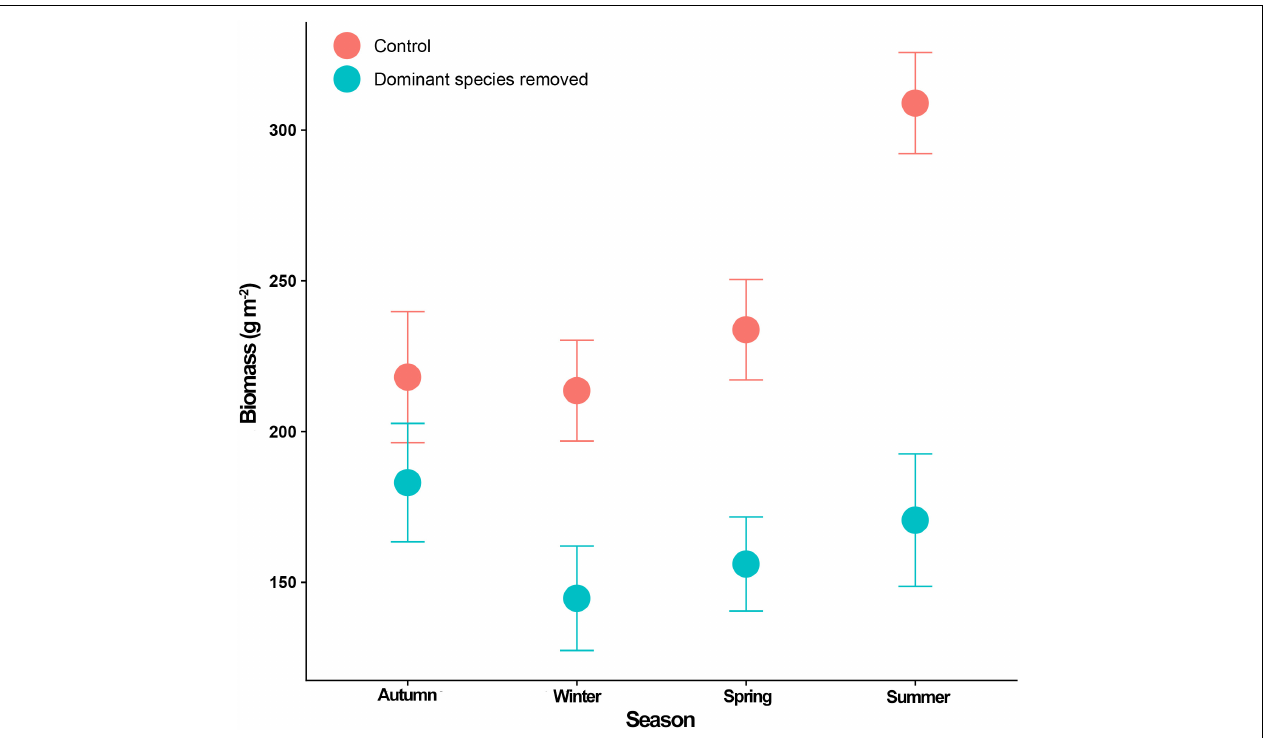
FIGURE 4 | Seasonal variation in overall community biomass ( ± SE) on control (red circles, n = 10) and disturbed (blue circles, n = 10) plots. Each season account with three replications (three seasonal